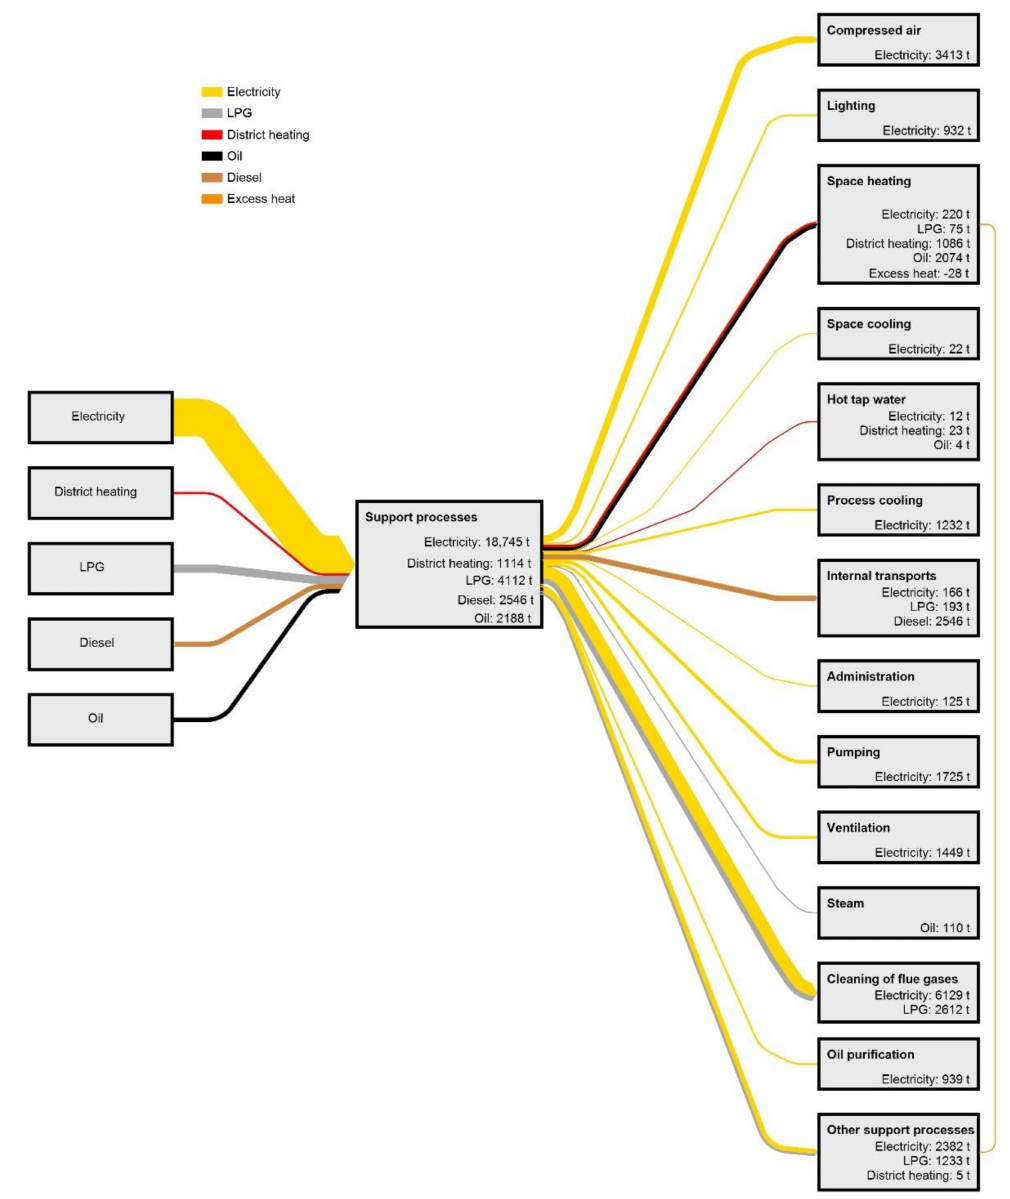
Figure 9. The GHG emissions of the aluminium industry and two aluminium casting foundries in Sweden regarding support processes. Processes occurring at several companies in the supply chain have been combined into one entry each. The average mix perspective and the emission factors in Table 1 were used here, as described in Section